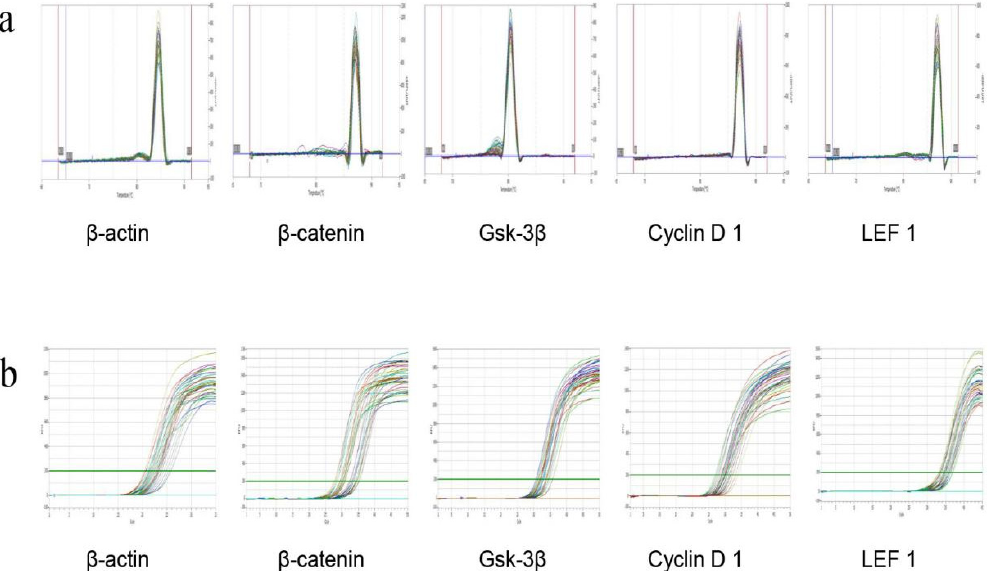
Figure 2. ( a ): The dissolution curve of mRNA RT PCR products of four indicators in mice skin tissue. ( b ) RT-PCR product amplification curves of four indicators in mice skin tissue.